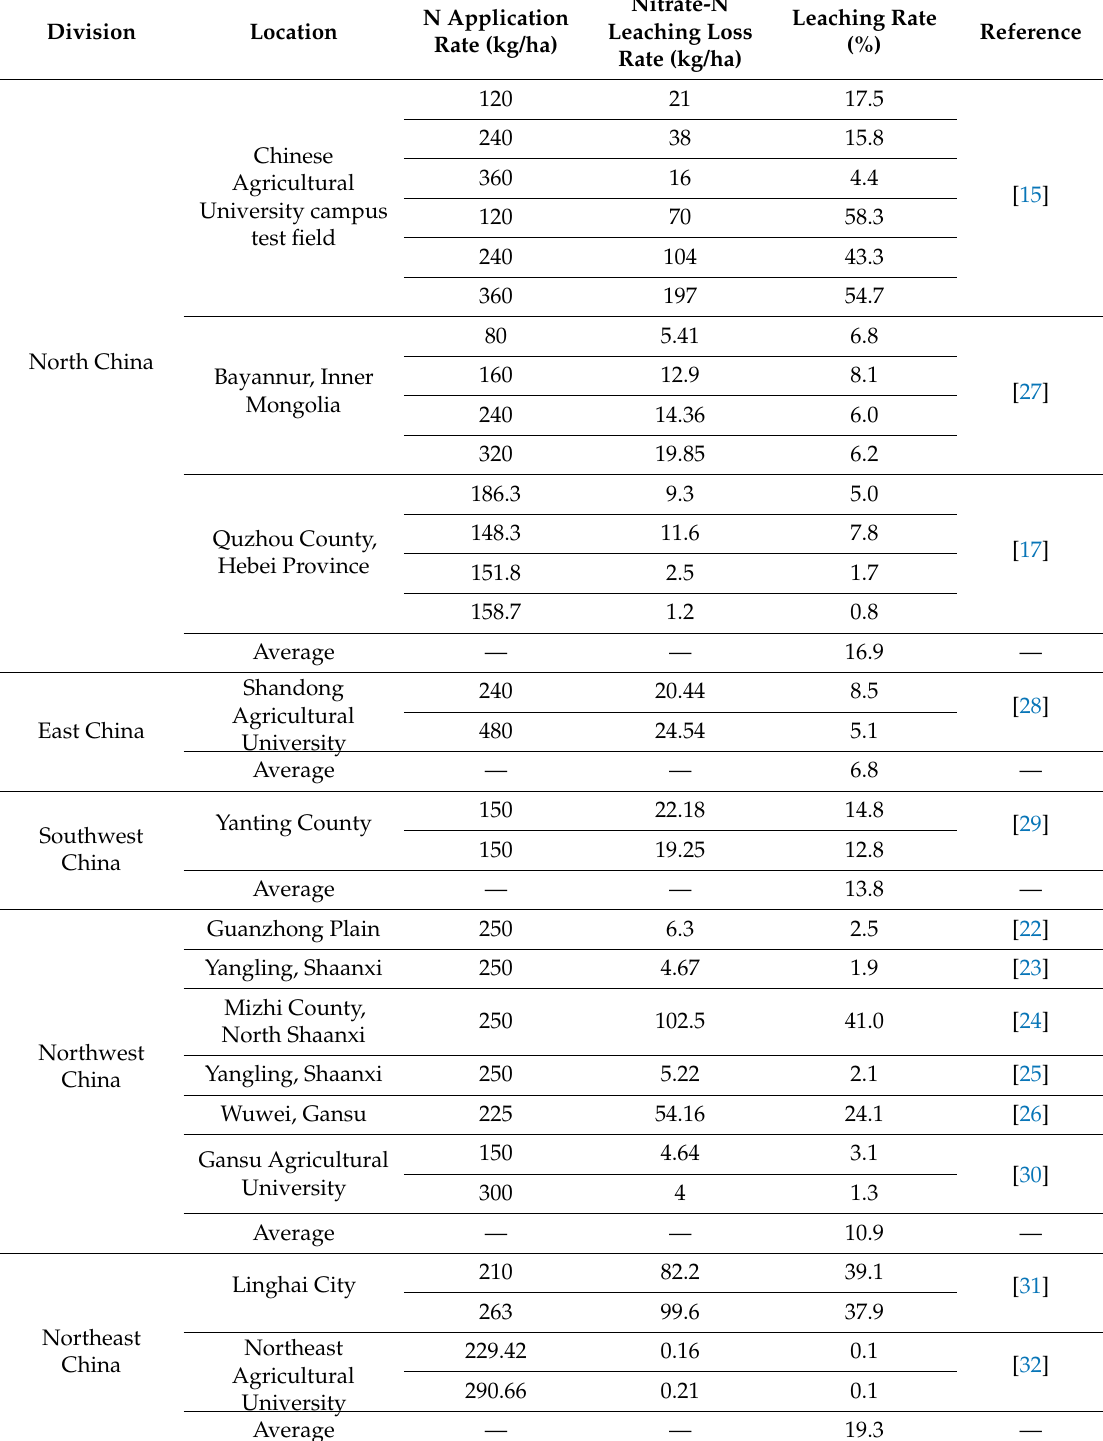
Table 2. Nitrogen application rate and nitrate-nitrogen leaching rate in key maize cultivation divisions.